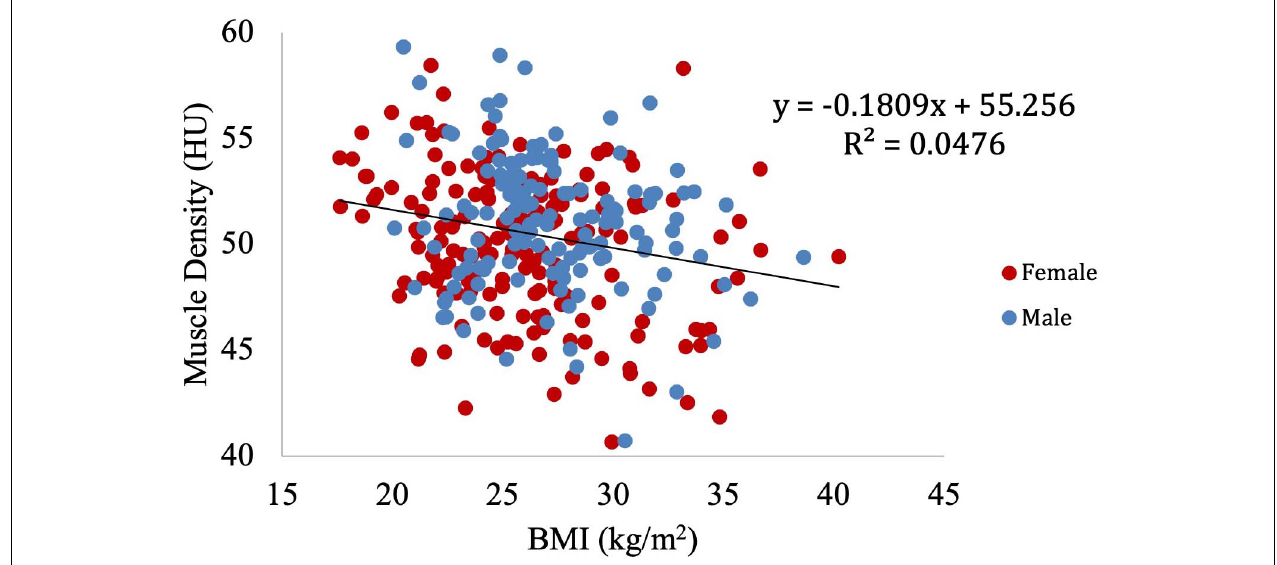
FIGURE 8 | Relationship between muscle density from CT and BMI ( p < 0.01). This relationship remained significant ( p < 0.01) after adjustment for IMCL/water.